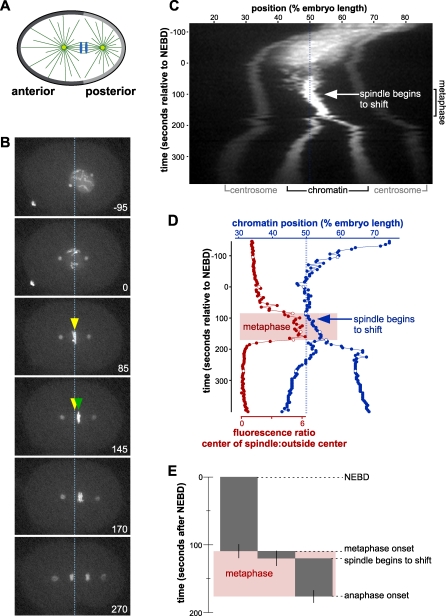
The Mitotic Spindle Begins to Shift Approximately 10 s after the Completion of Chromosome Congression(A) Diagram of the C. elegans zygote in anaphase, with chromatin represented in blue, microtubules in green, centrosomes in yellow, and anterior and posterior cortical PAR proteins in gray.(B) One-cell stage C. elegans embryo expressing histone H2B:GFP and gamma-tubulin:GFP, with time indicated in seconds before or after NEBD. Chromosomes complete congression to the metaphase plate at 50% embryo length (dotted blue line, yellow arrow) before the spindle becomes displaced posteriorly (green arrow).(C) Kymograph analysis of the embryo in (B), with the dotted blue line indicating 50% embryo length. The kymograph displays a time-series (y-axis) of a line from the anterior to posterior end of the embryo through the spindle (x-axis).(D) Quantitative analysis of the embryo in (B) and (C). Open circles at six timepoints correspond, from top to bottom, to the six timepoints in (B). Chromatin position is graphed in blue, and the degree of compactness of the chromatin is graphed in red, measured as a ratio of fluorescence intensities from the center of the spindle to directly outside this region, as detailed in Figure S1. Metaphase is indicated in pink.(E) Quantitative analysis of timing from 21 embryos imaged in multiple planes through the entire spindle and z-projected. Three intervals measured were from NEBD to metaphase onset as defined by completion of congression (left), from metaphase onset to the beginning of spindle displacement (middle), and from the beginning of spindle displacement to anaphase onset as defined by chromosome separation. The last two intervals define metaphase. Error bars represent the 95% confidence intervals for significance.